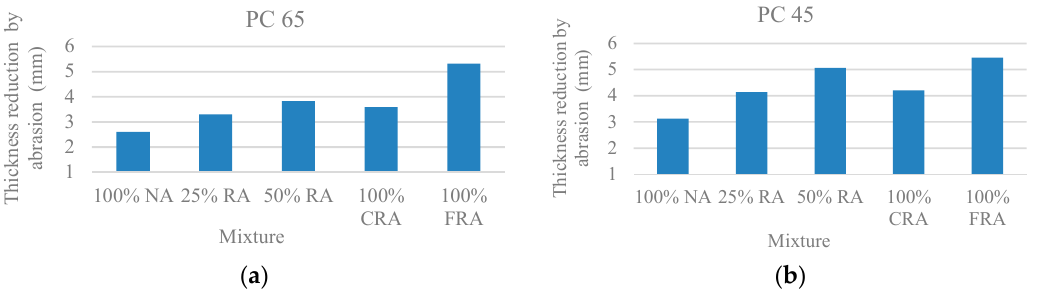
Figure 11. ( a ) Abrasion resistance at 91 days—wear depth (PC 65); ( b ) Abrasion resistance at 91 days—wear depth (PC 45).